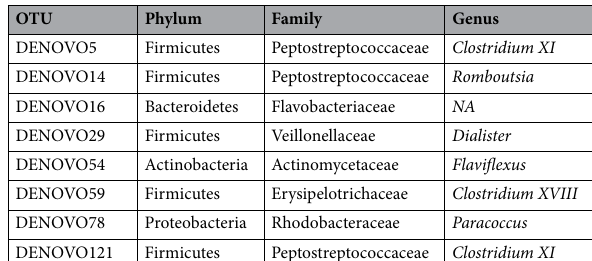
Table 1. OTUs that significantly differed in abundance within the gut microbiota of polar bears depending on diet type consumed (as shown in Fig. 3). Taxonomic information for each OTU is listed to genus level.